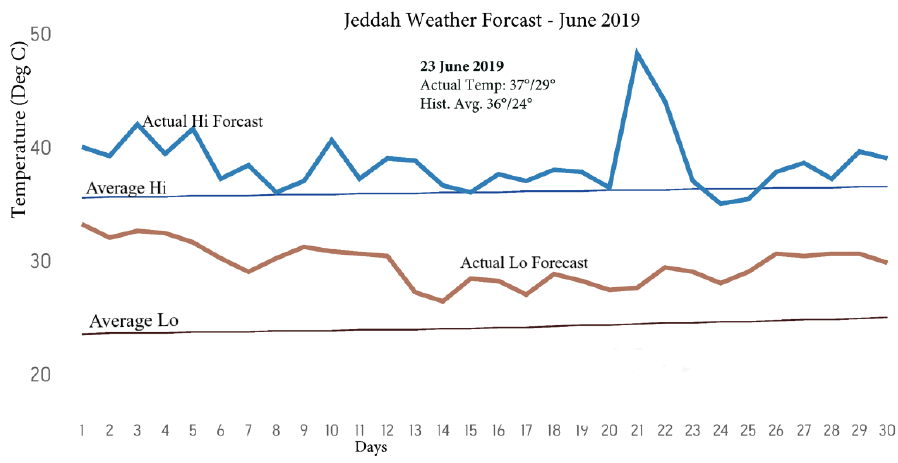
Figure 11. Jeddah, monthly weather for 23 June 2019 (Source: AccuWeather).